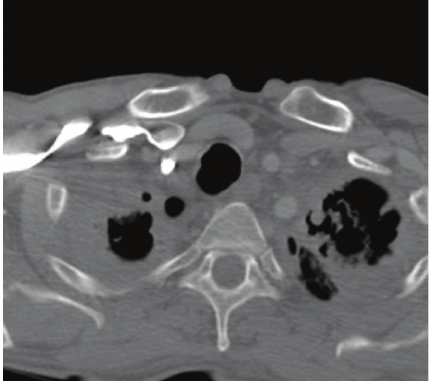
Figure 3: On scanogram a rather catastrophic view is demonstrated including cavitary lesions, extensive fibrosis, and consolidation mainly at the upper lobes.